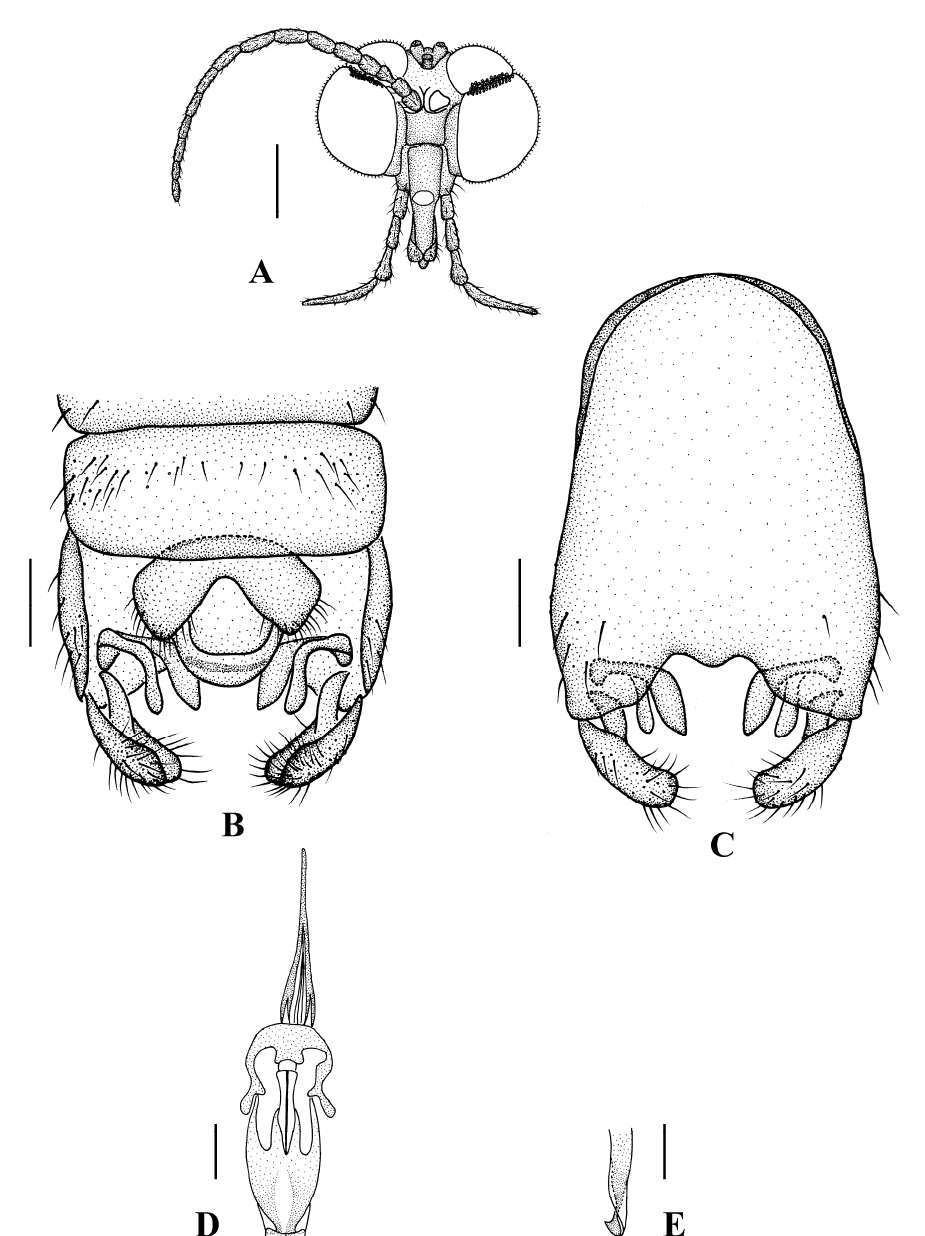
Figure 12. Blepharicera xinjiangica sp. nov. (male holotype). ( A ) male head, frontal view ( B ) male genitalia, dorsal view ( C ) male genitalia, ventral view ( D ) aedegal complex, dorsal view ( E ) tip of dorsal paramere, lateral view. Scale bars: 0.25 mm ( A ), 0.1 mm ( B – E ). Thorax (Figure 11B). Pronotum and propleuron brown without hairs. Mesonotum dark brown with posterior margin yellow, posterior 1/2 with the extensive light brown middle area and a brownish yellow narrow median stripe; scutellum light brown with anterior 1/3 yellow, numerous hairs grouped at posterolateral corner of scutellum; metanotum light brown; episternum light brown; epimeron yellow. The relative length of the femur, tibiae, and 1st to 5th tarsomeres in fore leg as 16:11:8:4:2.5:1:1, in mid leg as 14:10.8:6.5:3:1.8:1:1, in hind leg as 15.7:12.7:5:1.3:1:0.7:1. Fore coxa pale with basal 1/2 light brown, with light brown hairs; mid coxa with an appendage, pale with brownish black hairs; hind coxa pale with brownish black hairs; trochanters pale, anterior margin with black spot apically, with brownish-black hairs; femora brownish yellow with light brown ring